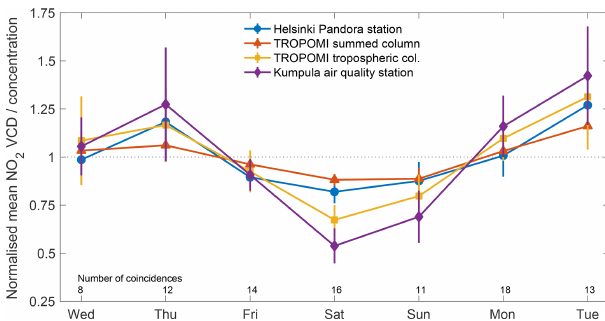
Figure 7. NO 2 weekly cycle in Helsinki. The average of tempo- rally collocated values for each day of the week for Pandora total columns (blue line), TROPOMI summed and tropospheric columns (red and yellow lines respectively) and surface concentrations as measured at the Kumpula AQ station (purple line) are shown. Error bars represent corresponding standard errors of the mean. All values have been normalised by the weekly mean of each